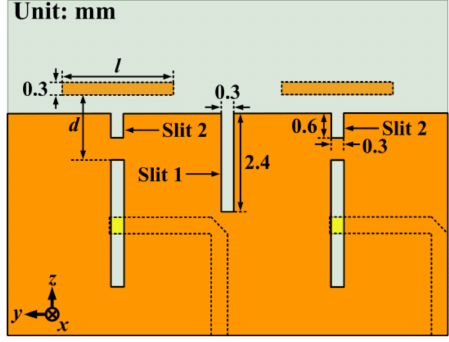
Figure 6. The 1 × 2 array antenna with directors and optimized slits.